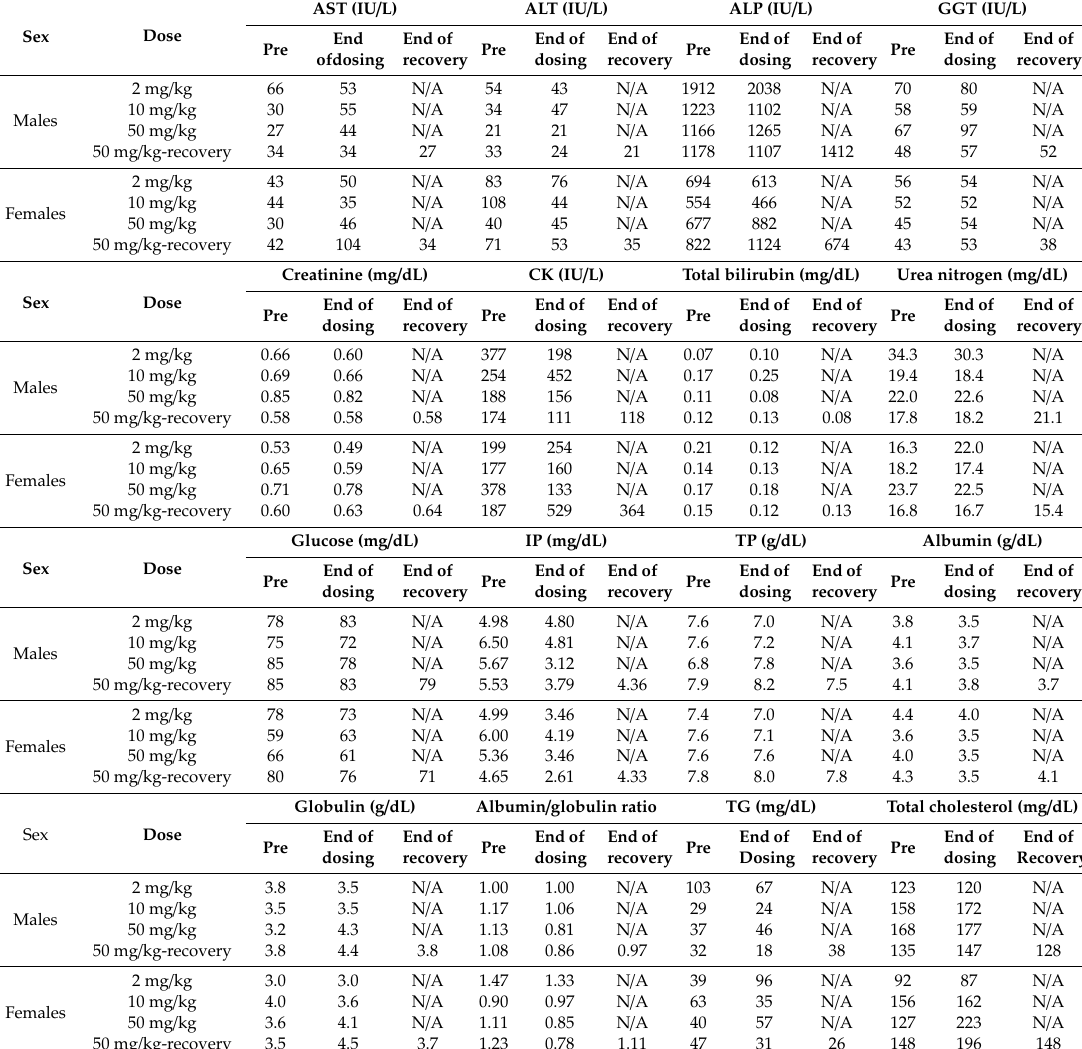
Table 3. Blood chemistry in cynomolgus monkeys that received